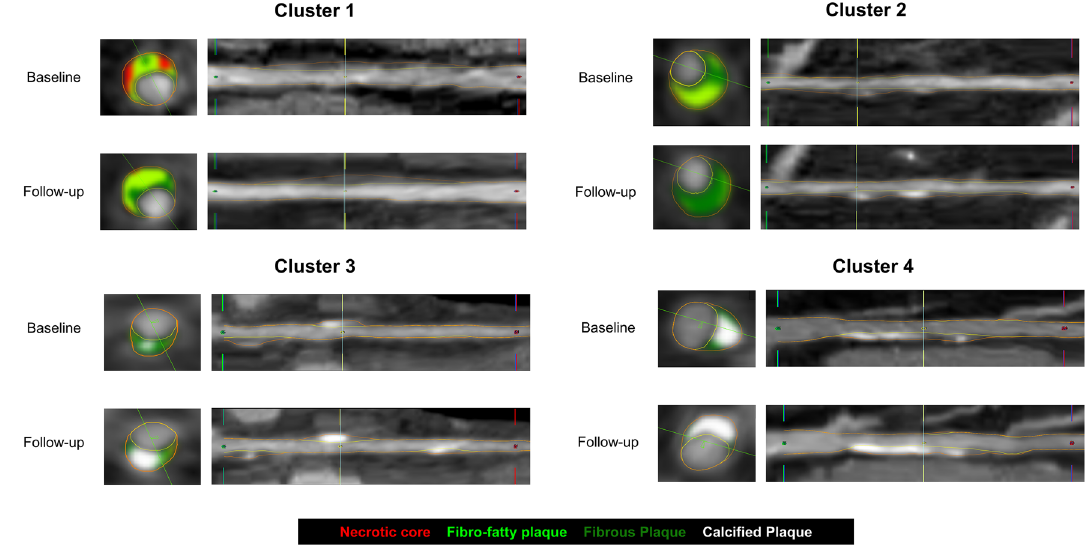
Figure 2. Representative cases from each cluster at baseline and